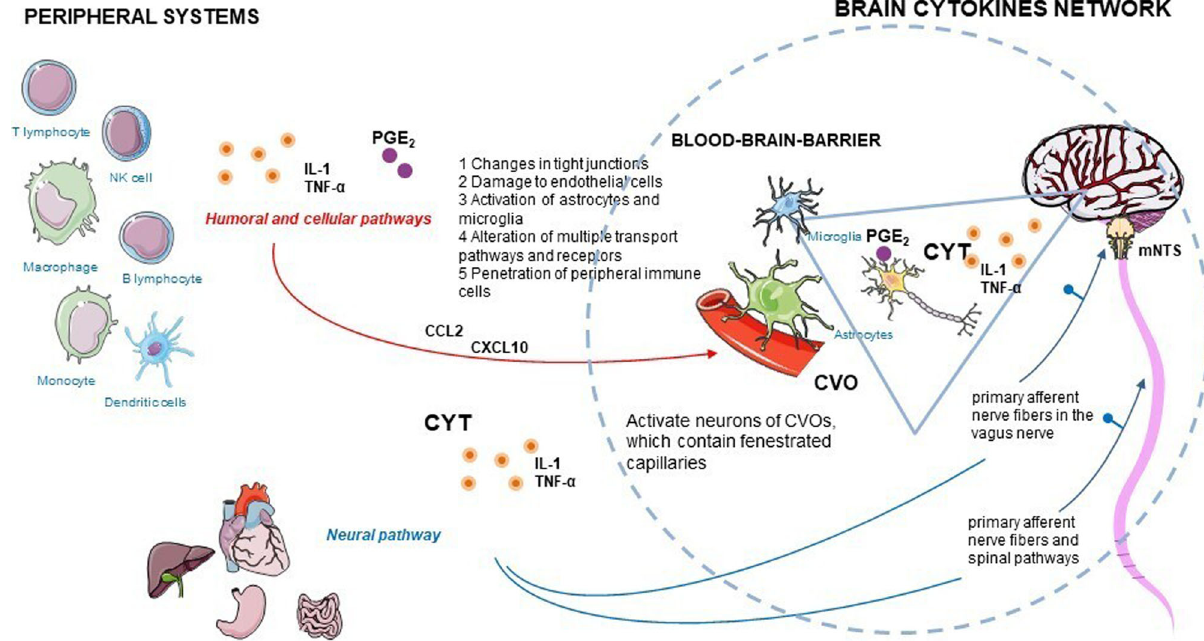
Fig. 1 Brain cytokines (CYT, orange circles) network and different suggested routes by which peripherally released in fl ammatory signals can bypass the blood – brain barrier and circumventricular organs (CVOs), and activate the central nervous system: humoral, cellular, and neural pathways. CCL-2: C-C motif chemokine ligand-2; CXCL-10: C-X-C motif chemokine ligand 10; IL-1: interleukin-1; mNTS: medial nucleus tractus solitarius; PGE 2 : prostaglandin E2; TNF- α : tumor necrosis factor- α